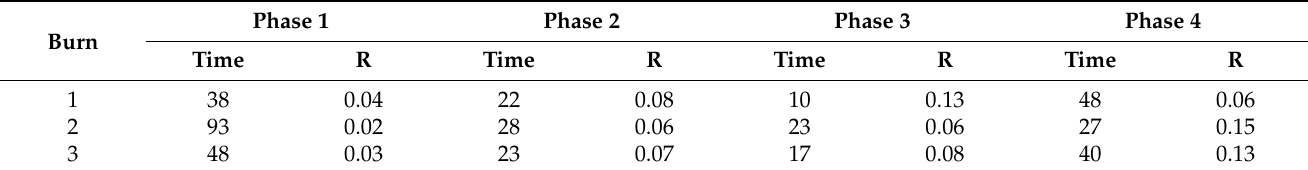
Table 3. Burning time and heating ramps on each phase during carbonization in Brazilian beehive kilns.